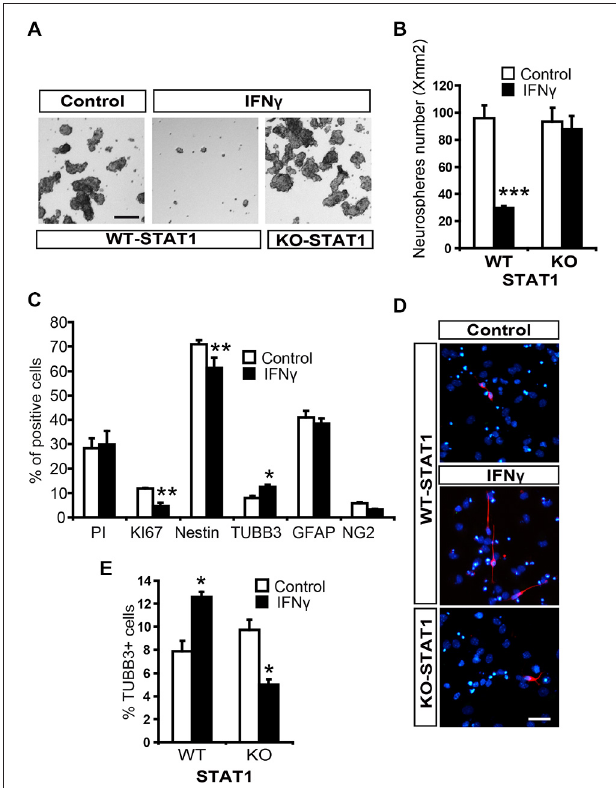
FIGURE 4 | IFN γγγ regulates proliferation and differentiation of NSCs from SVZ through STAT1. (A) Brightfield pictures showing how the number of secondary neurospheres was dramatically reduced by IFN γ and that STAT1 prevents cytokine actions. (B) Histogram showing how IFN γ impedes neurosphere formation through STAT1 ( n = 5). (C) Histogram demostrating the presence of neural cells after 7-day NSCs culture differentiation. The presence of IFN γ did not affect viability (PI incorporation); whereas the number of KI67+ and original Nestin+ cells decreased, and the number of committed neuroblasts (TUBB3+ cells) increased, without affecting oligodendroglial differentiation (NG2+ cells) or the number of GFAP+ cells ( n = 5). (D) Photographs illustrating the increased neurogenesis induced by IFN γ through STAT1. IFN γ induced a higher neuroblast (red) differentiation, which reverted in the absence of STAT1. Hoechst (blue) stained all nuclei ( n = 5). (E) Histogram demonstrating the presence of neuroblasts (TUBB3+ cells) originated from neural 7-day NSC culture differentiation. IFN γ improves neuronal differentiation in WT cultures but not in STAT1 deficient cells ( n = 5) in which a slightly reduction in neuroblasts was detected. Scale bar: (A) , 100 µ m and (D) , 40 µ m. Data are represented as mean ± SEM. * p < 0.05; ** p < 0.01; *** p <